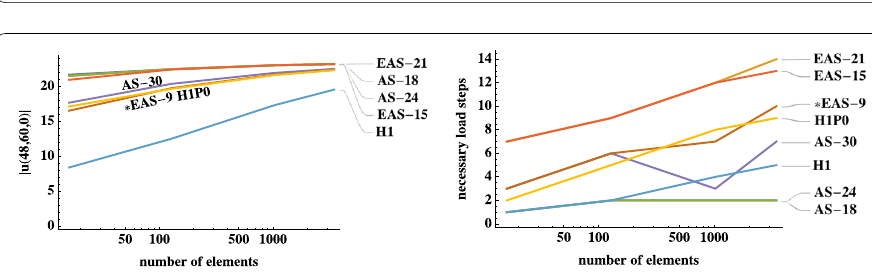
Fig. 16 Cooks membrane problem: geometry, representative mesh, deformed configuration and the boundary conditions